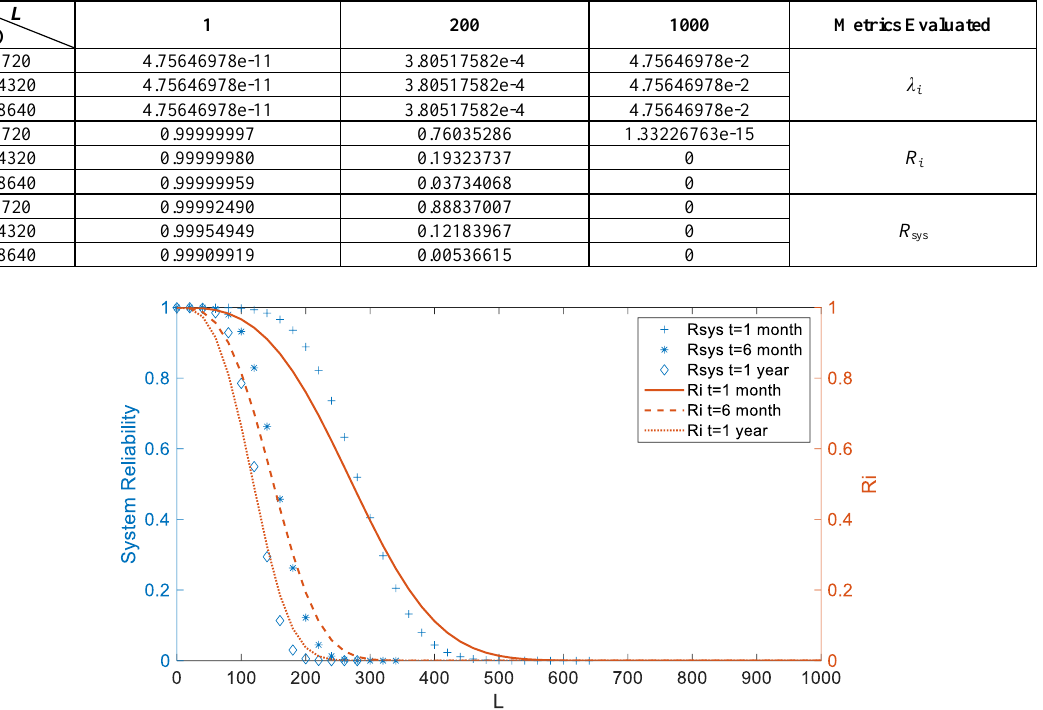
Figure 11. R i ( L ) and R sys ( L ) at different t for α i = 3 , 𝑖 ∈ {𝑆𝑤𝐴1, 𝑆𝑤𝐴2, 𝑆𝑤𝐵1, 𝑆𝑤𝐵2}